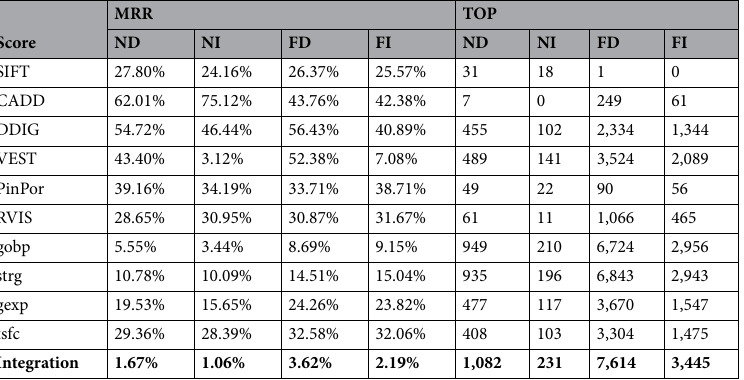
Table 3. Performance of each individual genomic data and the integrated score for the simulation studies. Each entry denotes MRR or TOP of each individual score, and the integrated score achieves the best